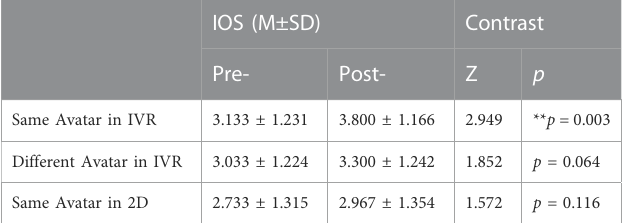
TABLE 4 Inclusion of Other in the Self scale between participant and avatar beforeandaftertherole-play(G1:SameAvatarinIVR;G2:DifferentAvatarinIVR; G3: Same Avatar in